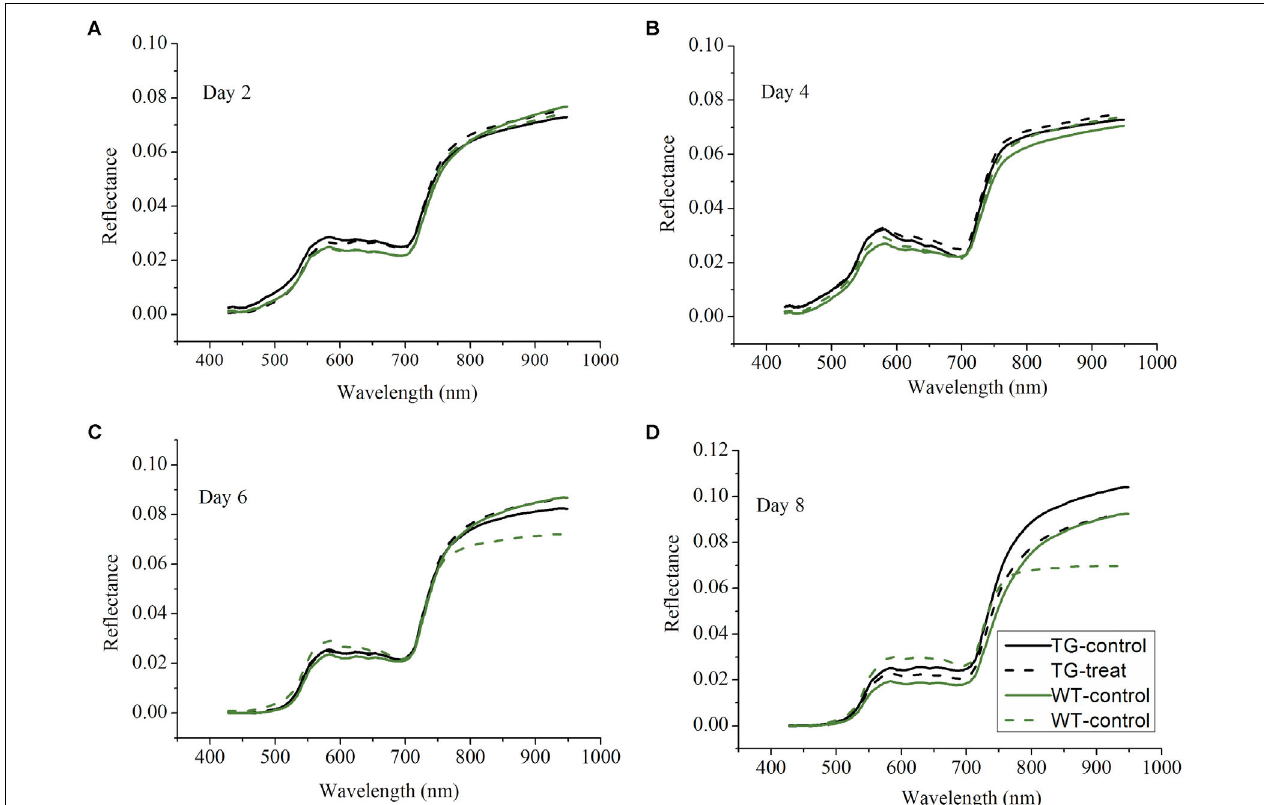
FIGURE 4 | Profiles of average spectra from the visible and near-infrared ranges after 2 (A) , 4 (B) , 6 (C) , 8 (D) days glyphosate treatment on TG and WT maize